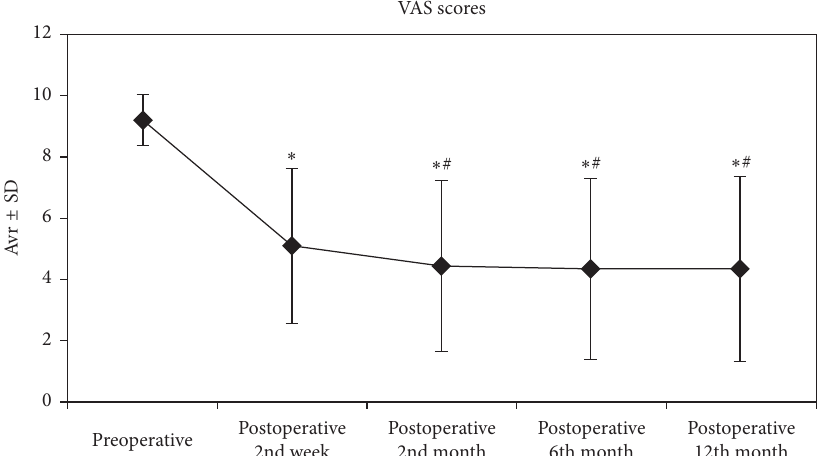
Figure 2: VAS values were taken during 12 months preoperatively and postoperatively. ∗ : statistically significant compared to preoperative values ( p < 0 , 01 ) . # : statistically significant compared to postoperative 2nd week ( p < 0 . 01 ) . Friedman test and Wilcoxon signed ranks test, p < 0 .